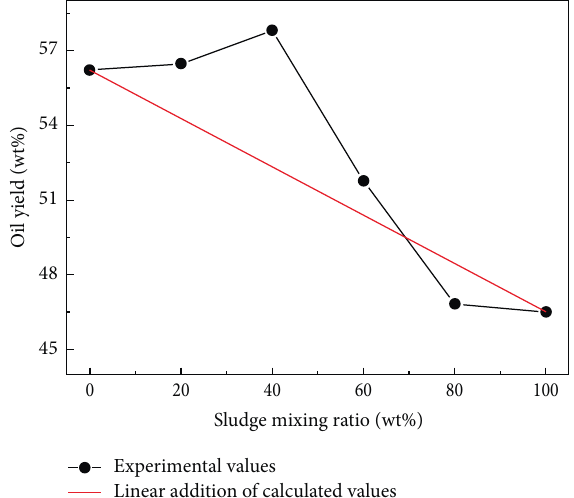
Figure 8: Copyrolysis of pine sawdust and sludge with gas and solid two-phase products as a function of mixing ratio.